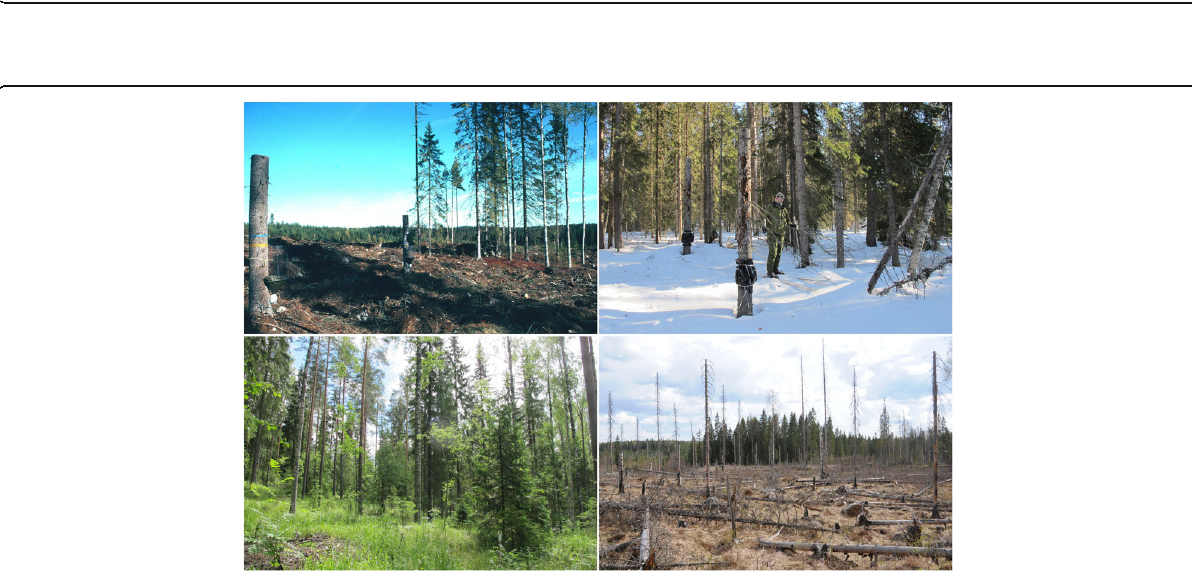
Fig. 2 Examples of practical retention and restoration. Top-left: retention tree group and high stumps in a clear-cut, first post-harvest summer (MONTA experiment, Finland, June 1996). Top-right: gap felling combined with high stumps, third post-harvest winter (Future Forest experiment, Sweden, March 2013). Bottom-left: selectively-felled mixed uneven-aged forest, third post-harvest summer (DISTDYN experiment, Finland, June 2012). Bottom-right: combined prescribed burning and intentionally killed, pushed-down trees at and around a paludified patch, seventh post- harvest summer (EVO experiment, Finland, May 2009). Photos © Matti